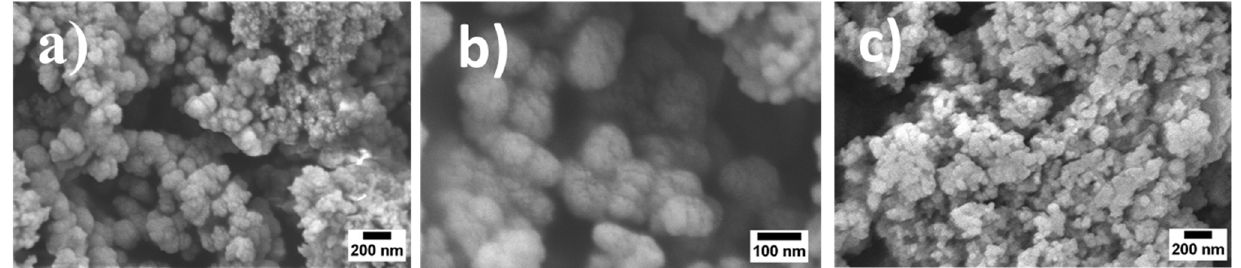
Figure 1. SEM images showing surface morphology of MBGNs at two magnifications ( a , b ) and Boswellia sacra -loaded MBGNs ( c ).